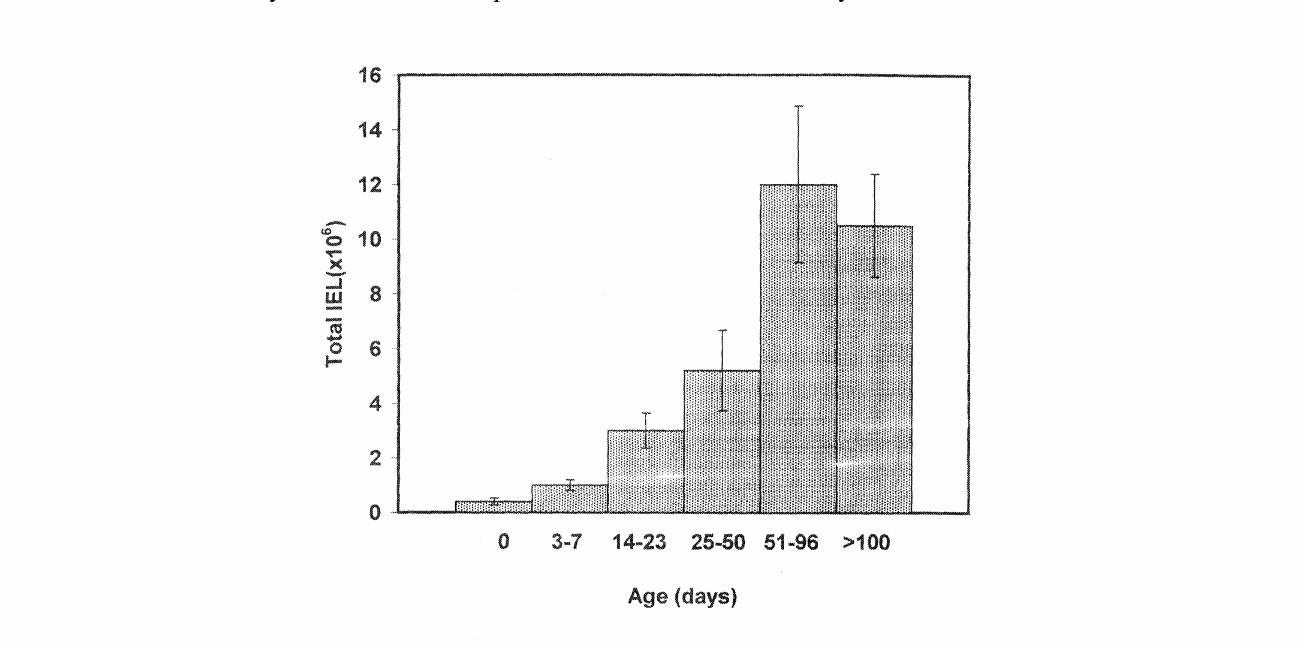
FIGURE Total IEL recovered at various ages. IEL were isolated from the small intestines of Sprague Dawley rats following the procedure of Kearsey and Studynk (1996) as described in the methods section. Shown are the average number of IEL S.E.M. per intestine. The num- ber of intestines used per isolation varied with age (see Methods). There were 4 isolations for 0 days and 10 isolations for 3-7 days; 5 isola- tions for 14-23 days, 6 isolations each for 25-50 days and 51-96 days and 10 isolations for > 100